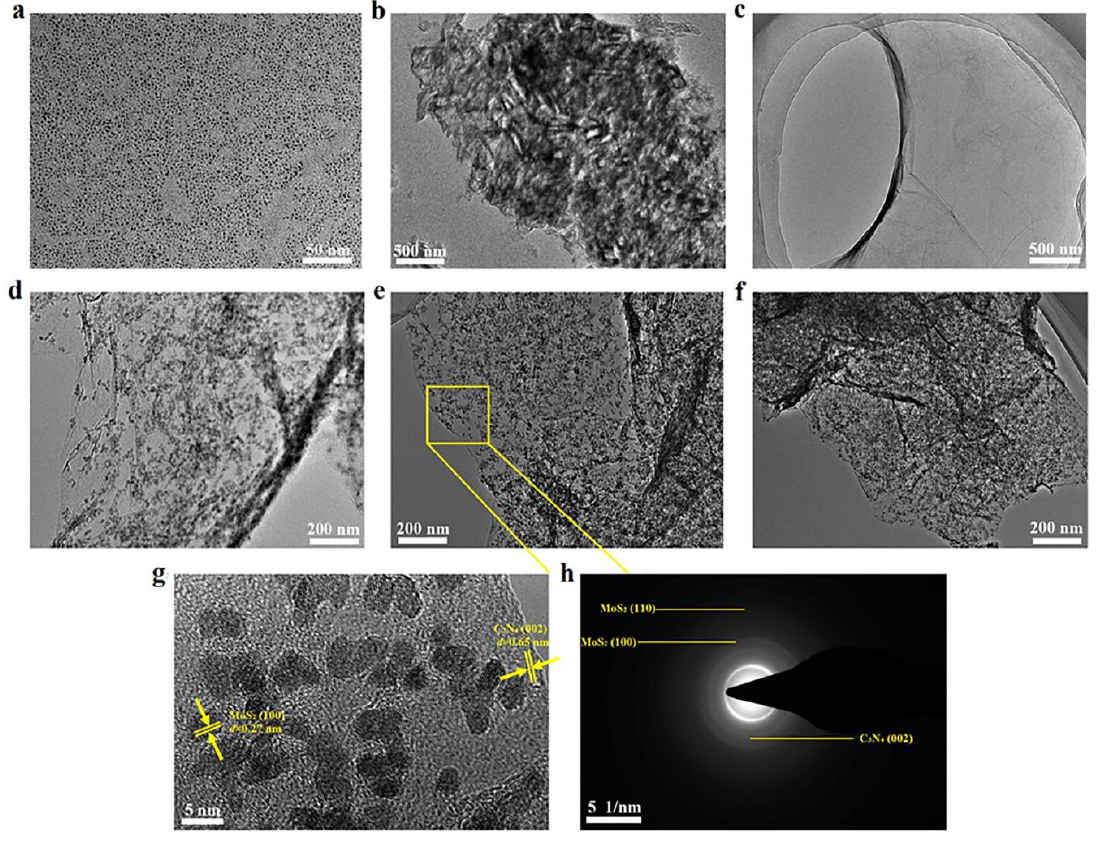
Figure 2. TEM images of MoS 2 QDs ( a ), bulk g-C 3 N 4 ( b ), CNNS ( c ), MoS 2 @CNNS(15) ( d ), MoS 2 @CNNS(30) ( e ), and MoS 2 @CNNS(45) ( f ); HRTEM image ( g ) and SAED pattern ( h ) of